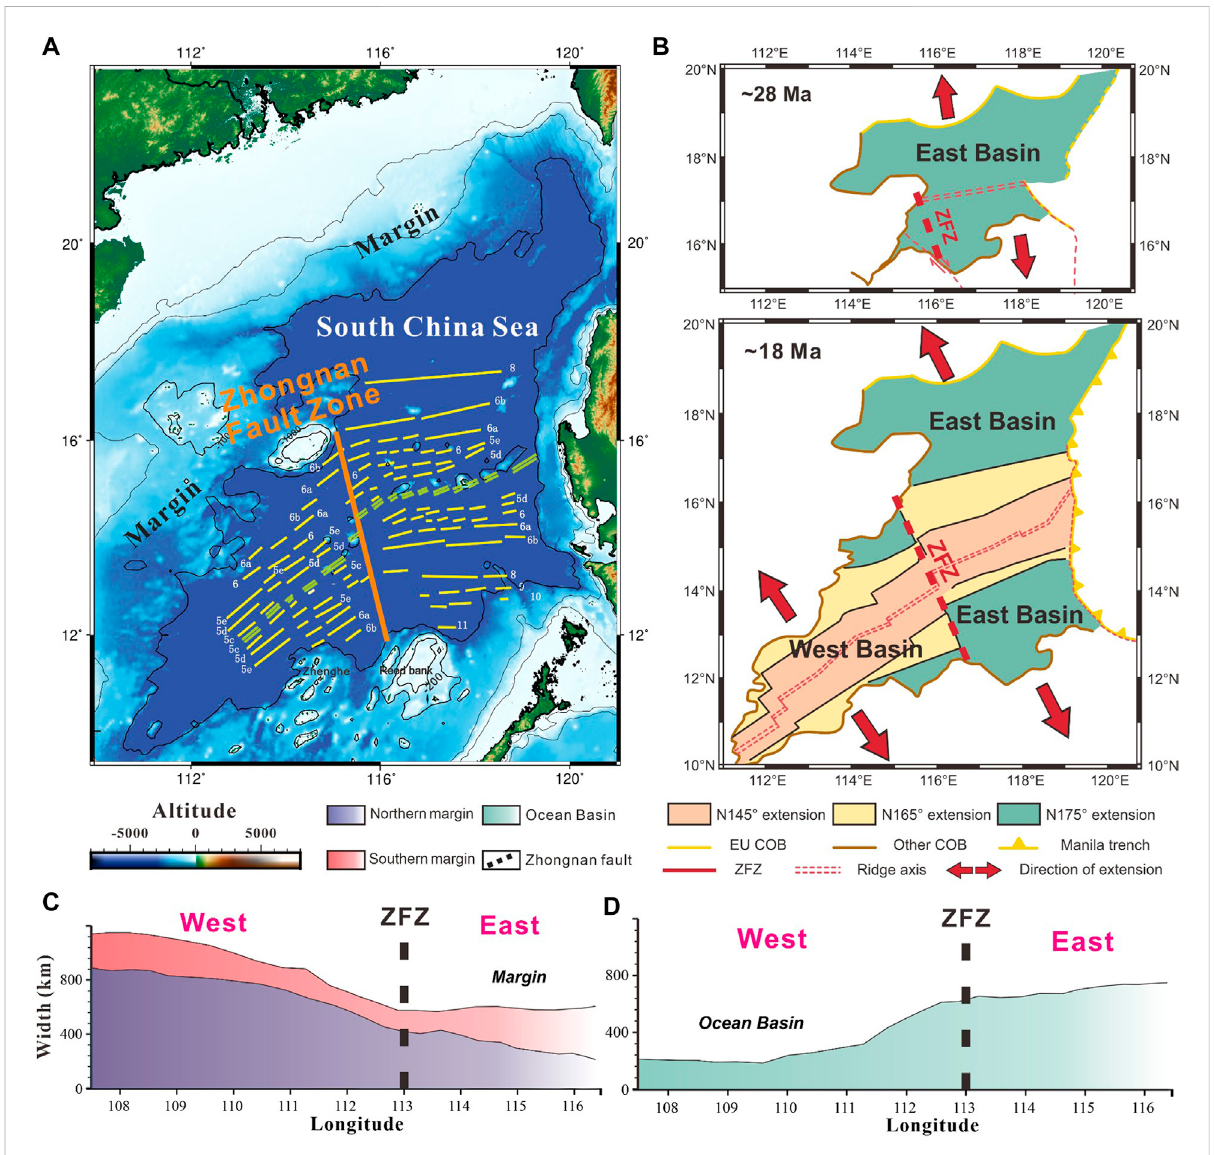
FIGURE 1 NaturalexampleoftheSouthChinaSeabasinshowingrifting/spreadingpropagationandthepre-existingtransformfault. (A) Simpli fi edtectonic backgroundoftheSouthChinaSeabasin.Yellowlinerepresentsthemagneticanomalies(fromSibuetetal.,2016).OrangelineistheZhongnanFault Zone (ZFZ). (B) Plate kinematic reconstruction sketches at different times (C – D) Variations in margin width and ocean basin width along the strike of the spreading ridge. We used the movement track of the South China Sea margin reconstructed by Bai et al. (2015) and the COB track reconstructed by Muller et al. (2016) to compute the basin and margin width along